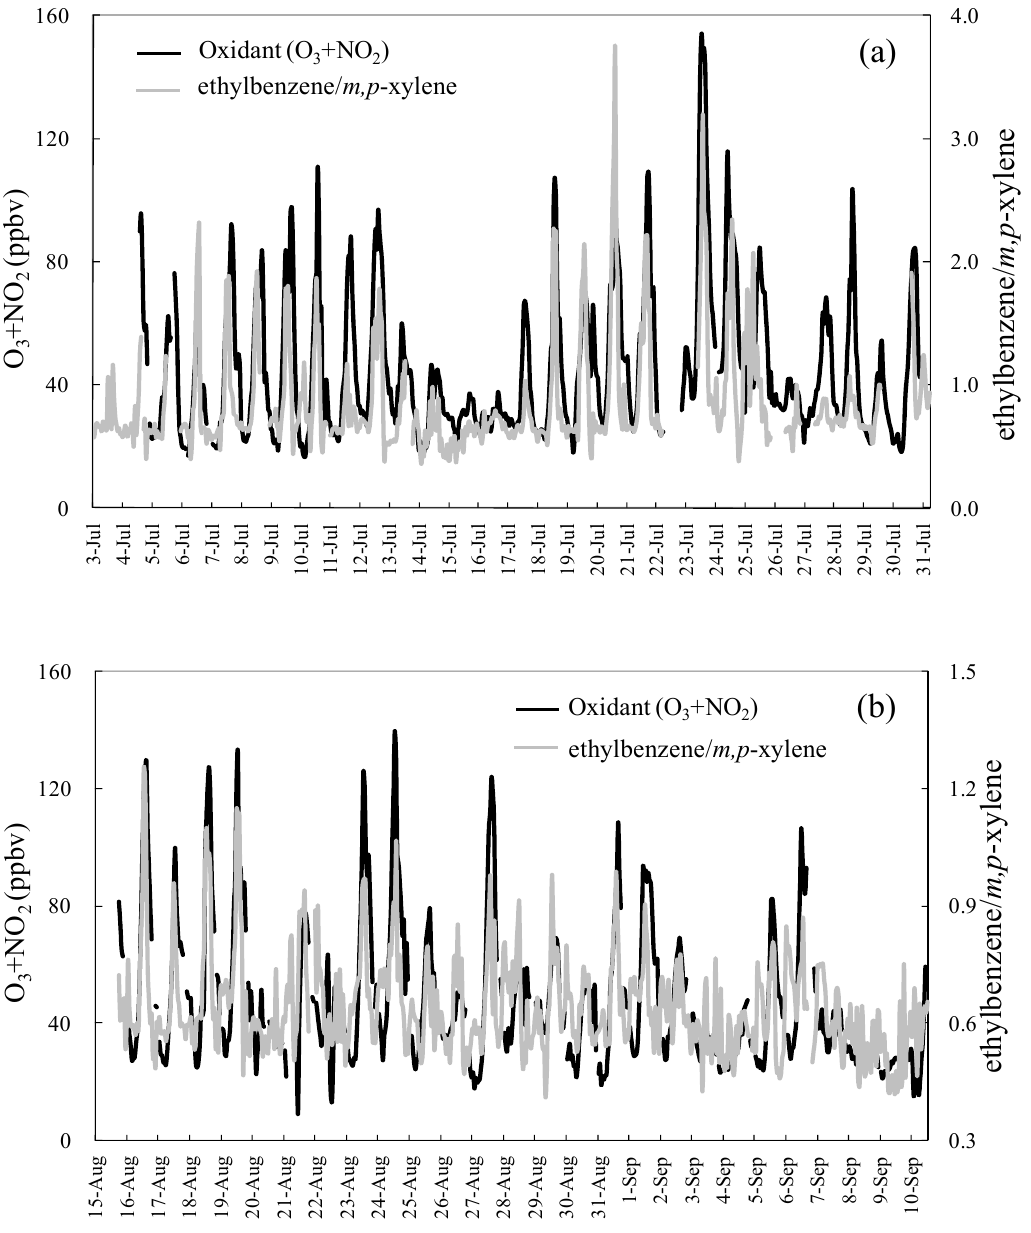
Figure 1. Time-series of oxidant (O 3 + NO 2 ) observations and E / X ratios at ( a ) Backgarden (BG), PRD and ( b ) PKU, Beijing.